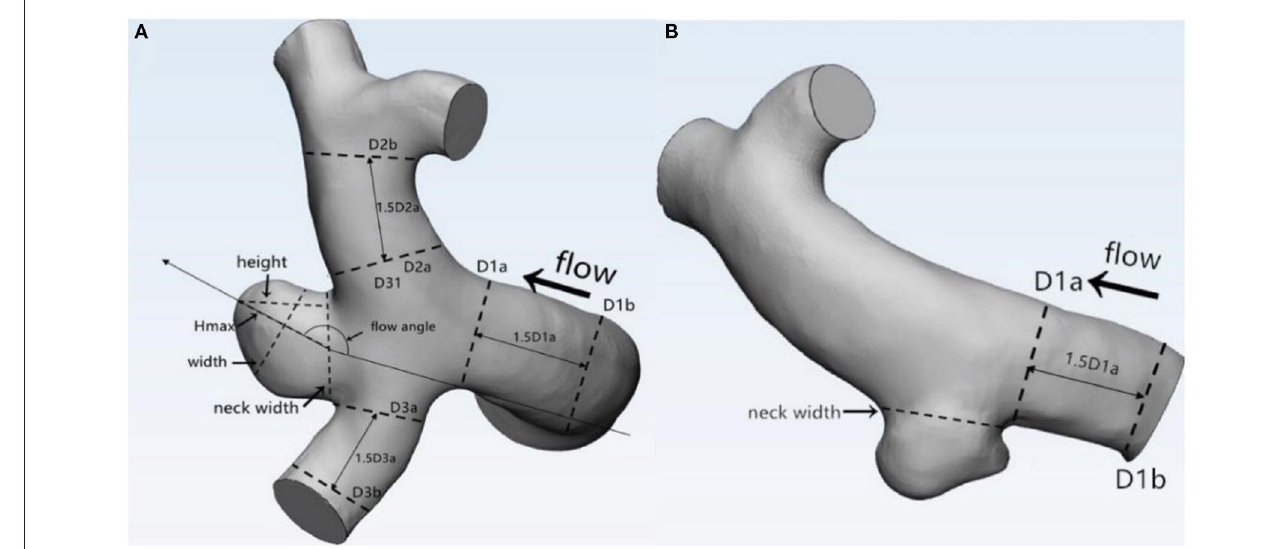
FIGURE 1 | Definitions of morphological parameters ( A : Bifurcation aneurysm, B : Sidewall aneurysm): Maximum size: the maximum distance of the dome from the neck plane; Neck width: the largest cross-sectional diameter of the aneurysm neck; Hmax: the maximum distance of the dome from the centroid of the neck plane; Height: the perpendicular distance of the dome from the neck plane; Width: the maximum diameter perpendicular to height; H / W ratio = height/width; bottleneck factor (BNF) = width/neck width; aspect ratio (AR) = height/neck width; size ratio (SR) = Hmax/DV, and DV were determined by averaging the diameter of the cross-section of a vessel (Da) just proximal to the neck of the aneurysm and the diameter of the cross-section (Db) at 1.5 times Da from the neck of the aneurysm. DV (mean diameters of parent vessels) = [(D1a + D1b)/2 + (D2a + D2b)/2 + (D3a + D3b)/2 + … (Dna + Dnb)/2]/n.